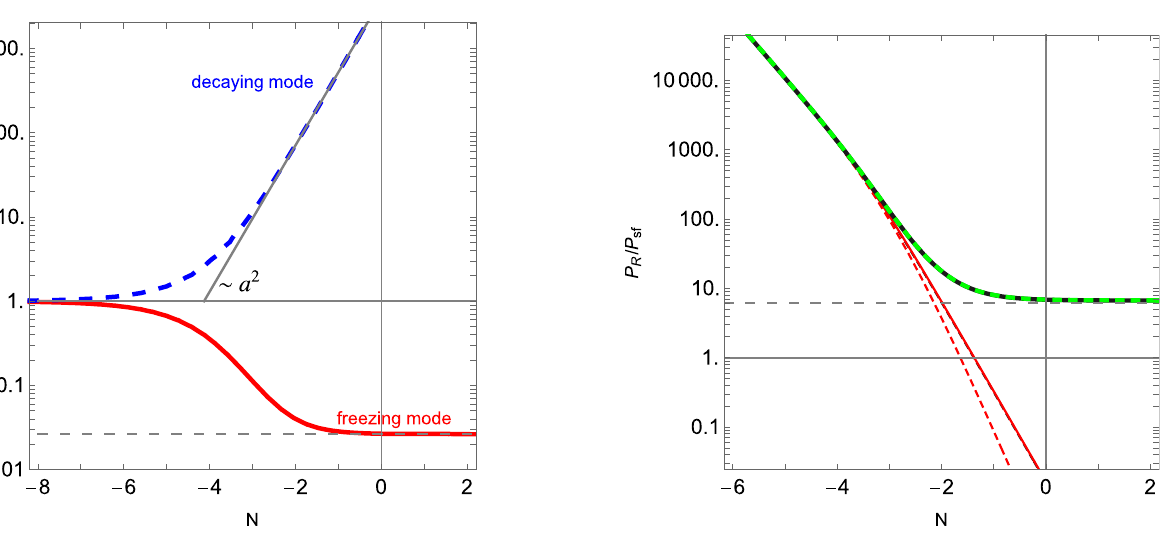
Fig. 3 Numerical calculations in single-field effective theories with constant reduced sound speed; model described in Sect. 5.1. Left panel: evolution of the sound speed given by Eq. (6) for initial conditions lead- ingtoafreezingadiabaticmode(redsolidline)andforinitialconditions leading to a decaying adiabatic mode (blue dashed lines); thin dashed single-field theory with a constant, reduced sound speed, but rather by by an effective single-field theory with modified dispersion relations. Evolution of the effective sound speed calculated from (6) and evolution of adiabatic perturbations